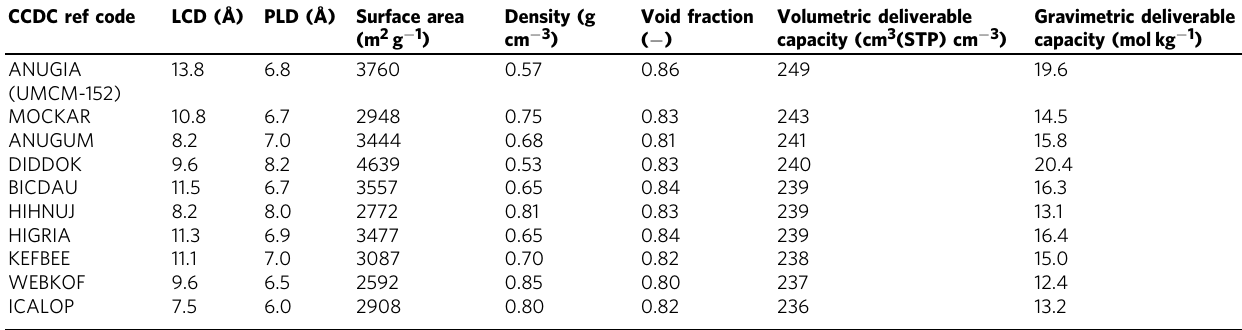
Table 1 Top 10 structures identi fi ed for volumetric O 2 storage along with their calculated textural properties and deliverable capacities obtained at 140 bar storage and 5 bar release pressures at 298 K CCDC ref